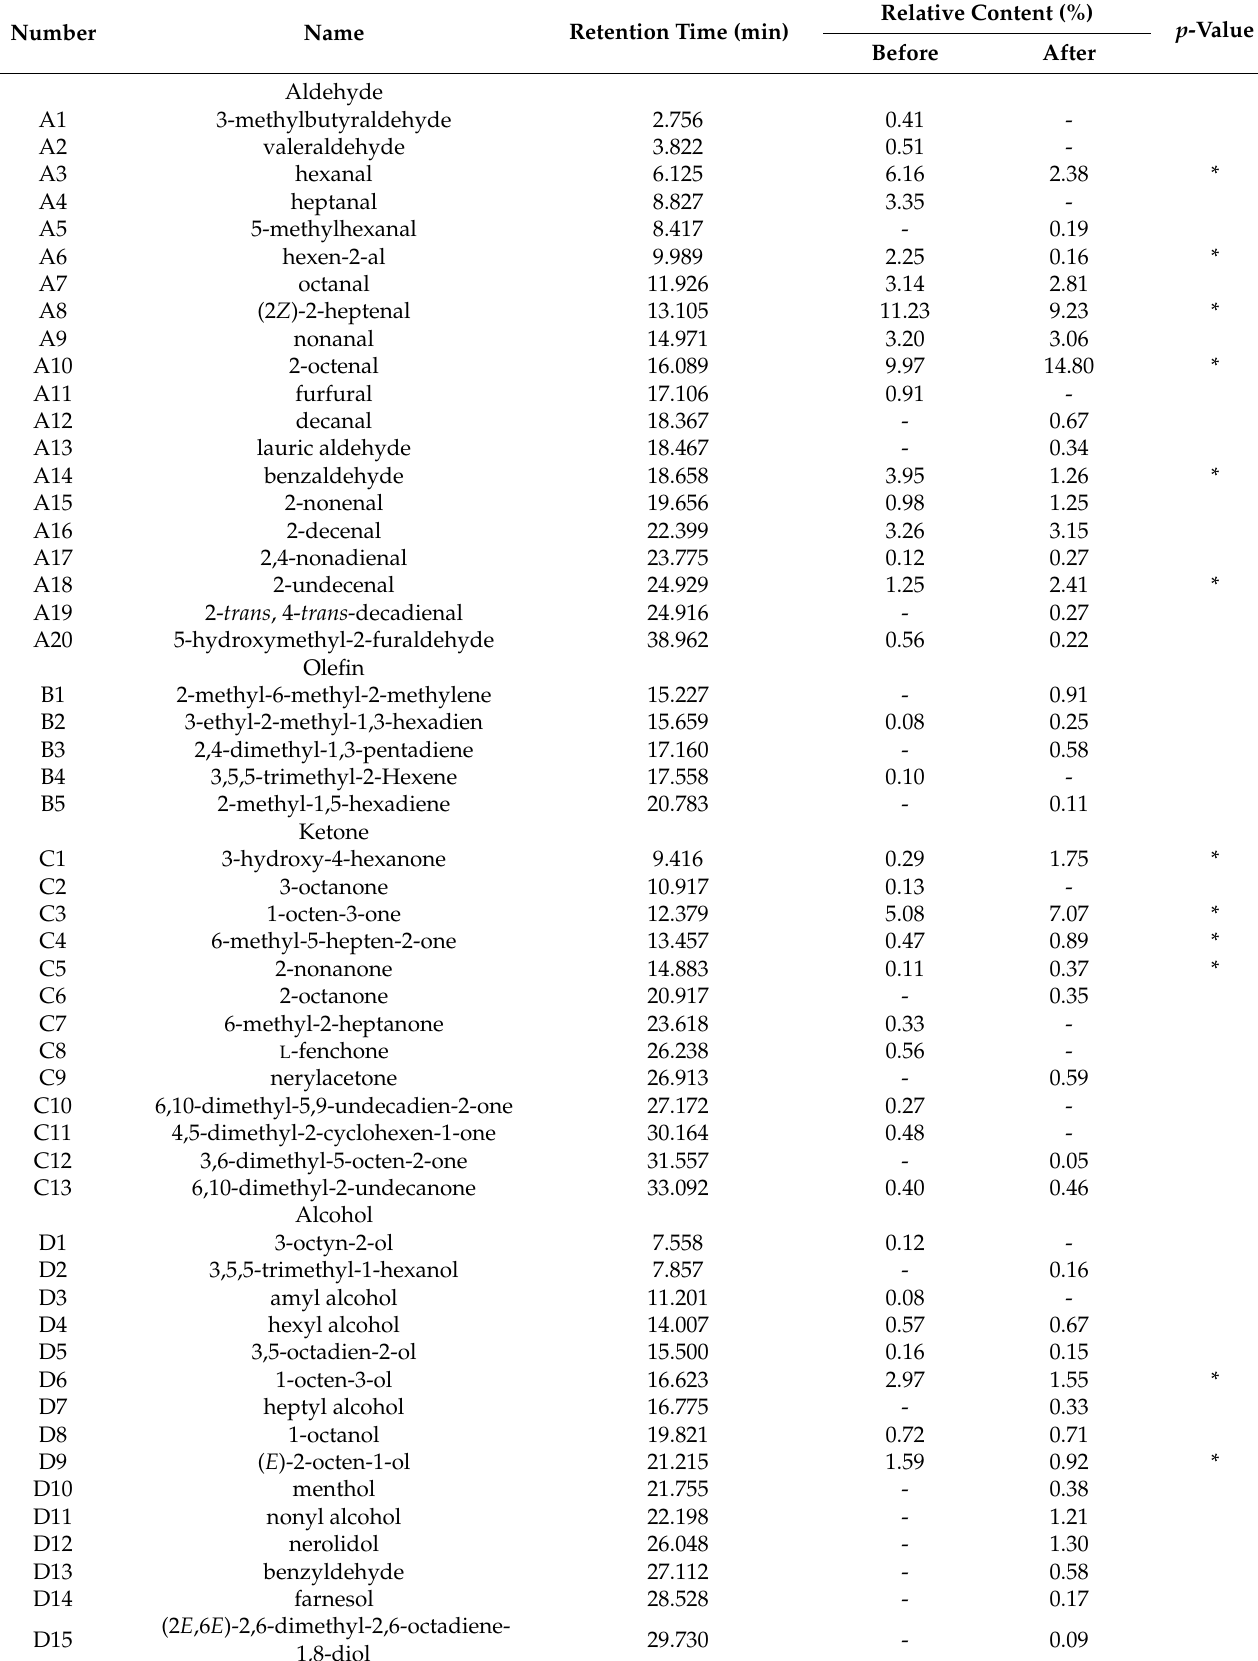
Table 2. Main volatile compounds in the R–B mixed juice before and after fermentation with L. plantarum